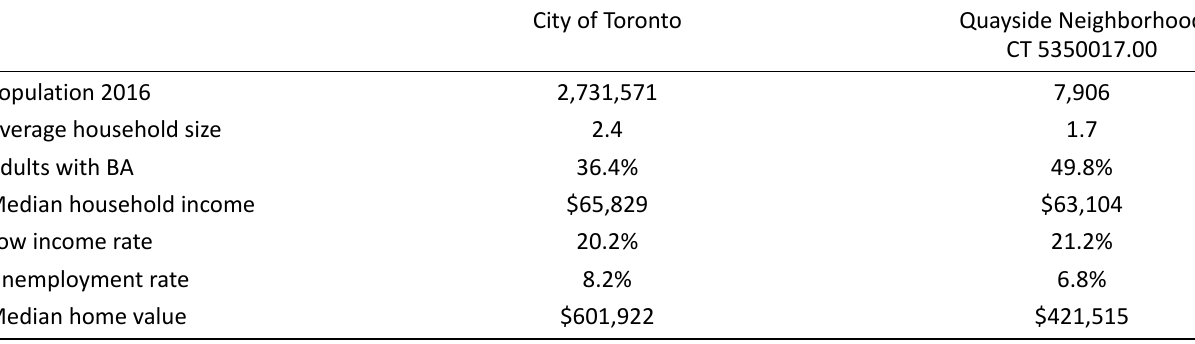
Table 2. Socio-economic characteristics of the Quayside area 2016 according to Statistics Canada